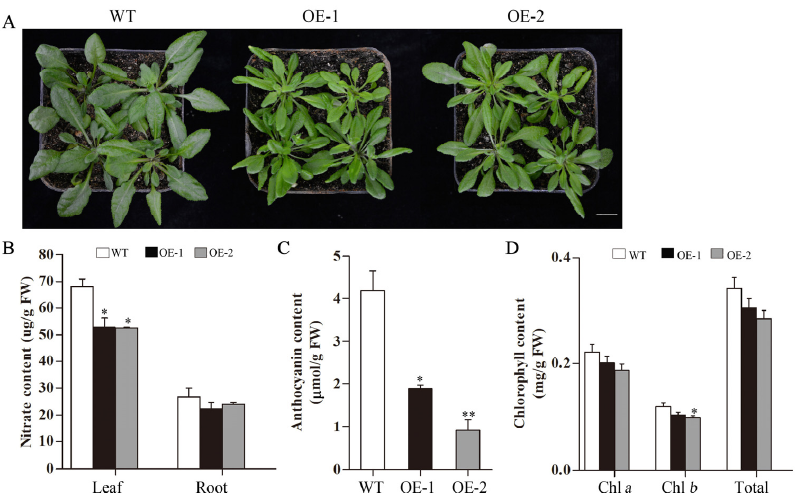
Figure 6. Phenotype and nitrate, anthocyanins, chlorophyll contents of transgenic Arabidopsis plant hosting CsLBD39 gene. ( A ) The phenotypes of the 35-day-old transgenic Arabidopsis and WT plants. Bar = 1 cm. ( B ) Nitrate, ( C ) total anthocyanins, and ( D ) chlorophyll contents of 35-day-old transgenic Arabidopsis and WT plants. The data are expressed as mean ± standard deviation of three biological replicates ( n = 3). Asterisks (*) indicate that the value is significant difference compared to the WT (* p < 0.05; ** p < 0.01).